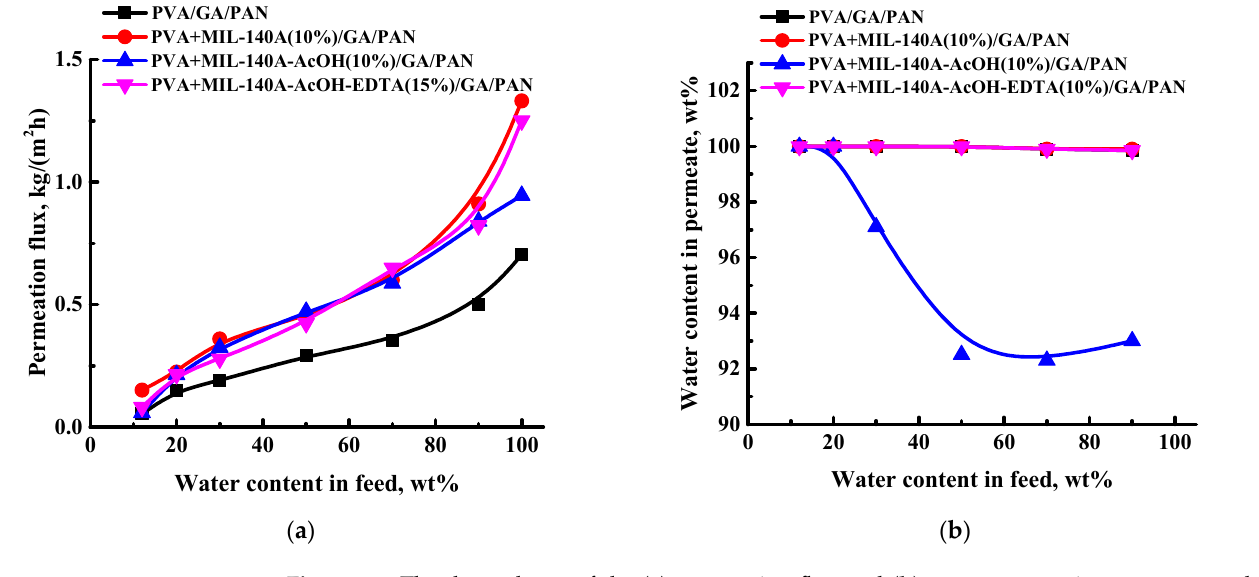
Figure 10. The dependence of the ( a ) permeation flux and ( b ) water content in permeate on the water content in the feed for the cross-linked composite PVA and PVA/Zr-MOFs(10%) membranes in pervaporation dehydration of isopropanol (12–100 wt% water) at 22 ◦ C. The water content in the permeate for the PVA/GA/PAN, PVA+MIL-140A(10%)/GA/PAN, and PVA+MIL-140A-AcOH- EDTA(10%)/GA/PAN membranes was equal to ca. 99.9 wt%.